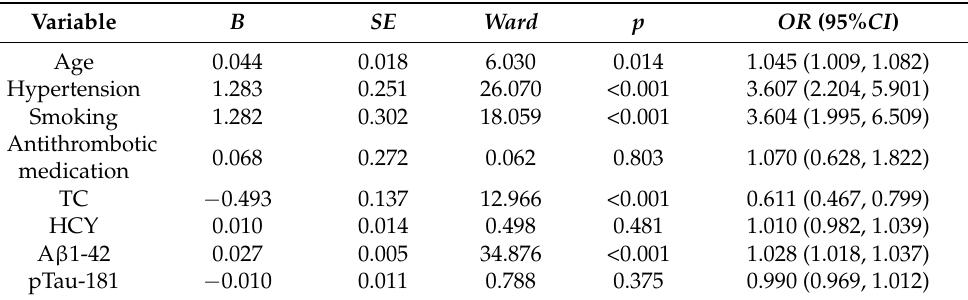
Table 2. The results of the multivariate analysis of the risk factors for